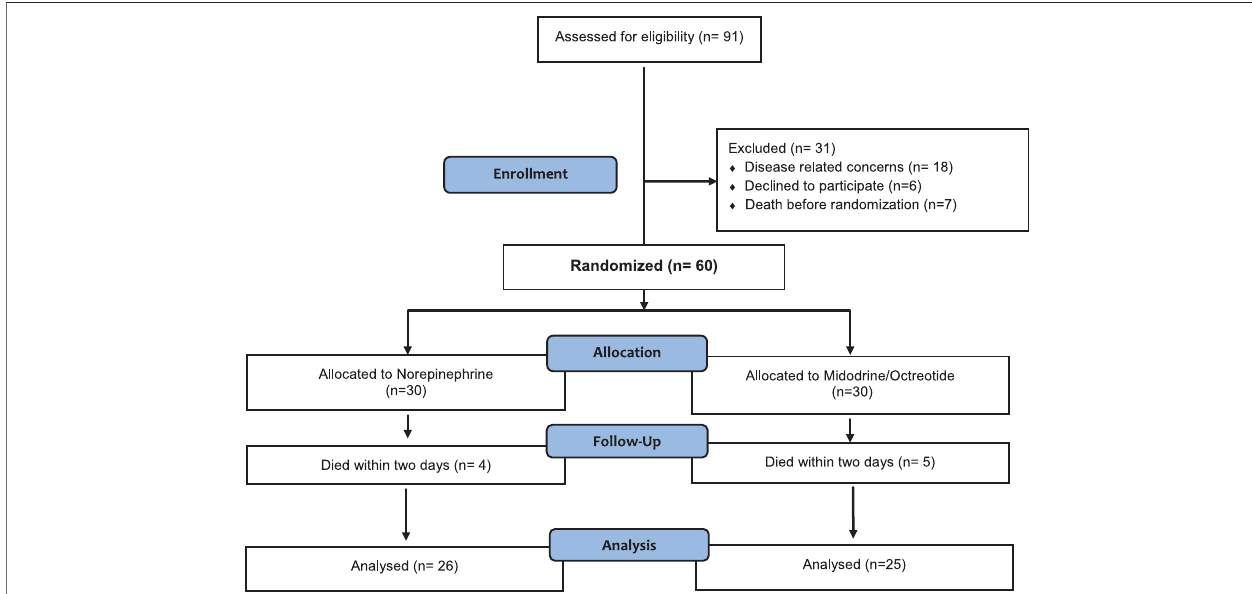
FIGURE 1 | CONSORT fl ow diagram showing the fl ow of patients throughout the study.